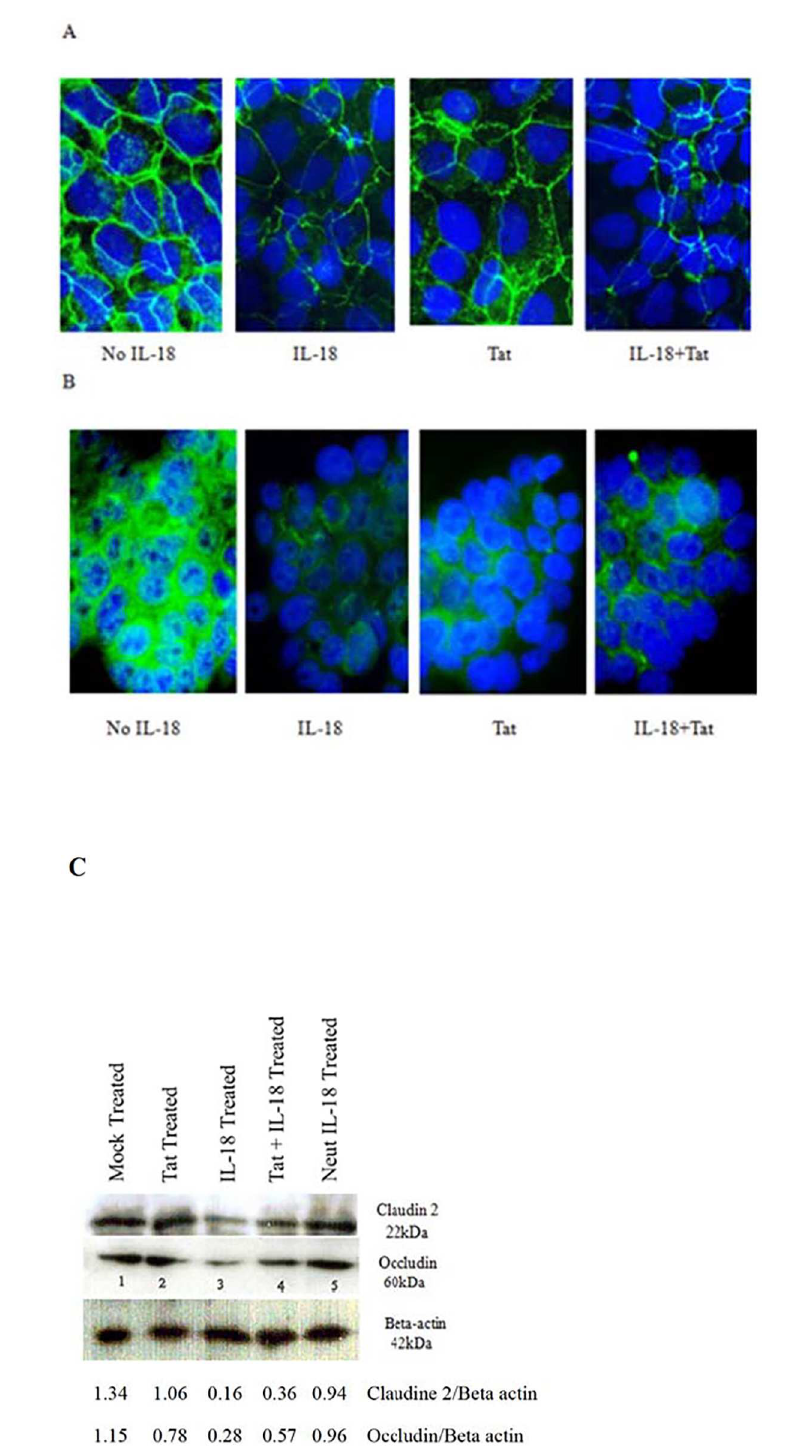
Fig 8. The effects of IL-18 on the expression of Tight Junction proteins in the intestinal cell monolayers. The cell monolayers were treated with IL-18 (10 ng/ml) and/or with Tat (100 ng/ml) for 24 hours, after which the cell monolayers were washed with PBS and stained with either protein specific rabbit antibodies or control antibodies (negative control), washed and stained with FITC-conjugated goat anti-rabbit antibodies. The cells were also stained with DAPI and examined under a fluorescent microscope and imaged. Staining of Caco2 monolayers for